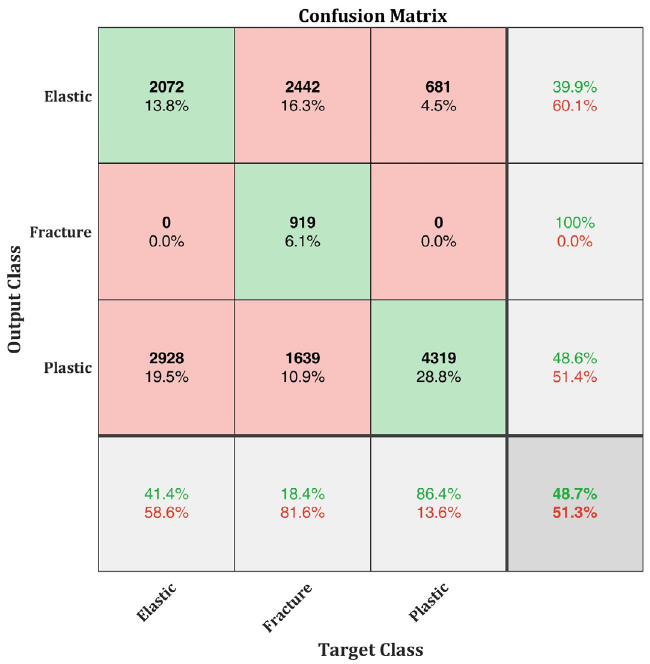
Figure 9. Confusion matrix of the original SqueezeNet without k-fold cross validation.